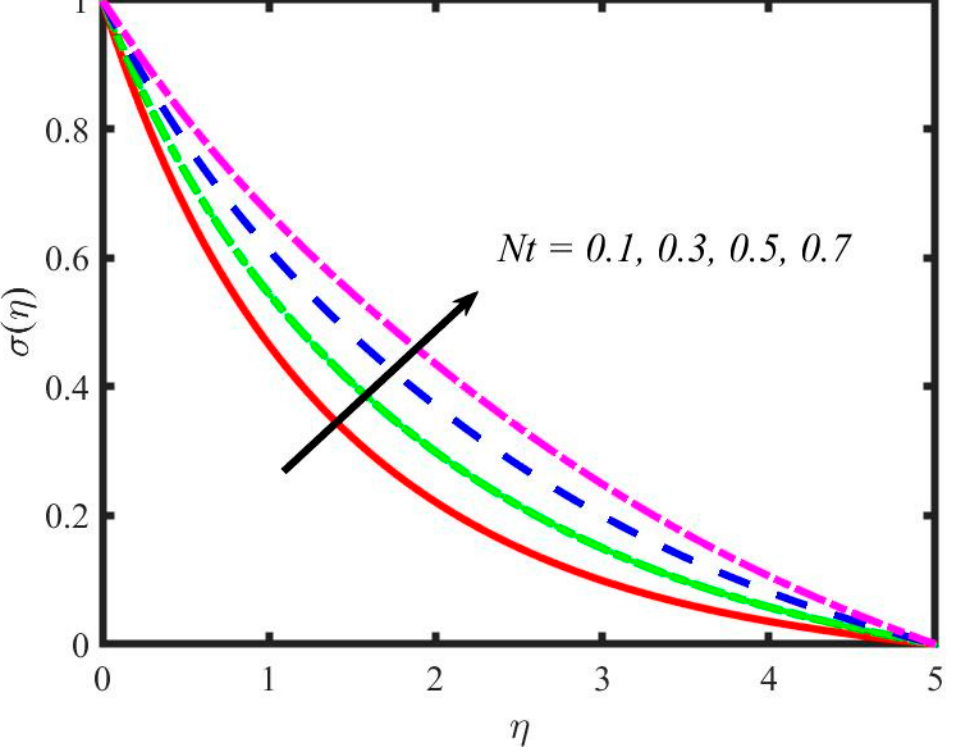
Figure 18. Variations in nanoparticle concentration for thermophoresis parameter.